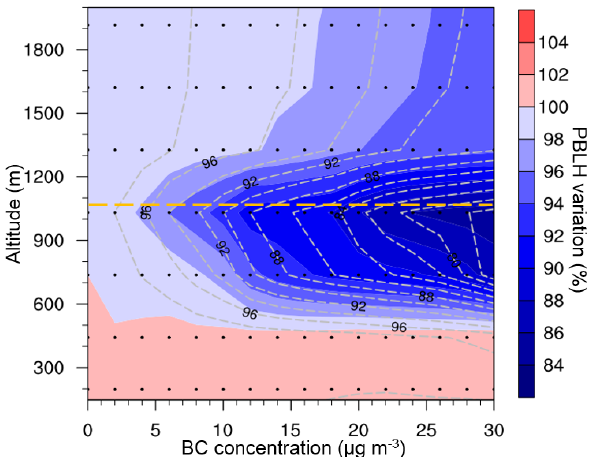
Figure 4. PBL height (contour map) and turbulence exchange co- efficient (grey dashed isoline) variations in percentage as a function of the altitude and mass concentration of BC aerosol layers. Note: each dot on the figure represents an experiment with different BC input. The x axis gives concentrations in the center of the inputted BC plume, while the y axis gives the altitude of the residing plume. The yellow dashed line represents the original PBL height without any BC plume.